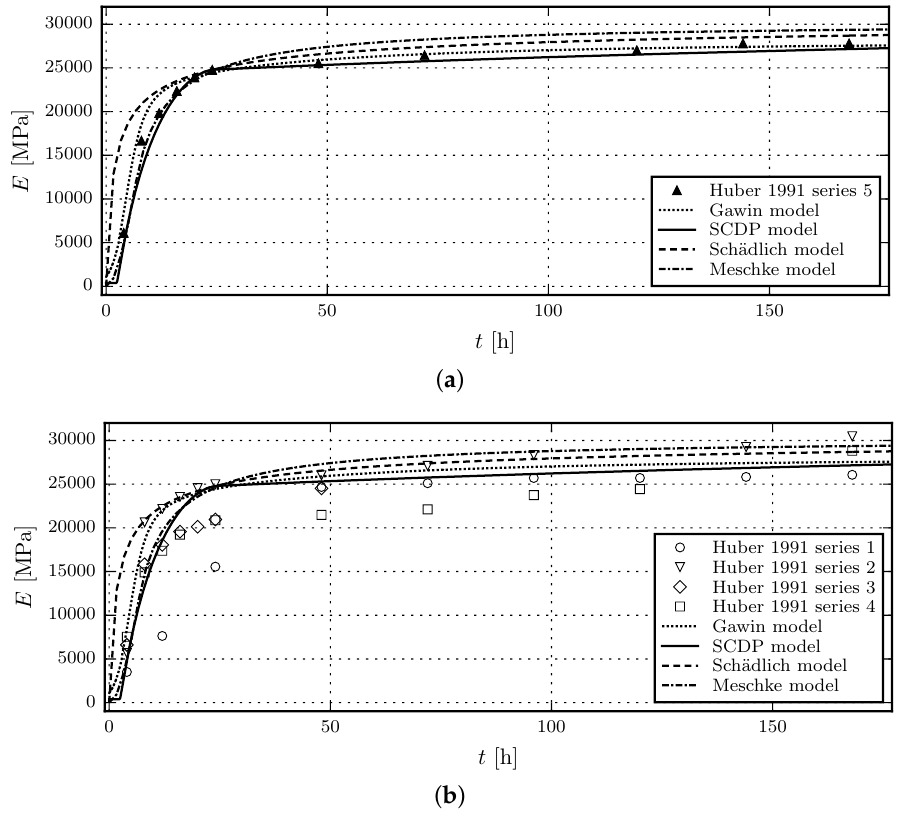
Figure 2. Evolution of the Young’s modulus: ( a ) Results of the calibration of the shotcrete models based on test data of test series 5 by Huber [15]; ( b ) Validation of the shotcrete models by means of the data of test series 1 to 4 in